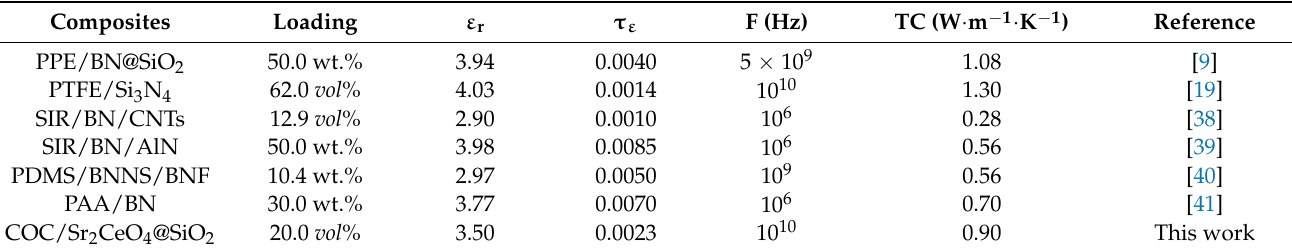
Table 2. Performance comparison of different